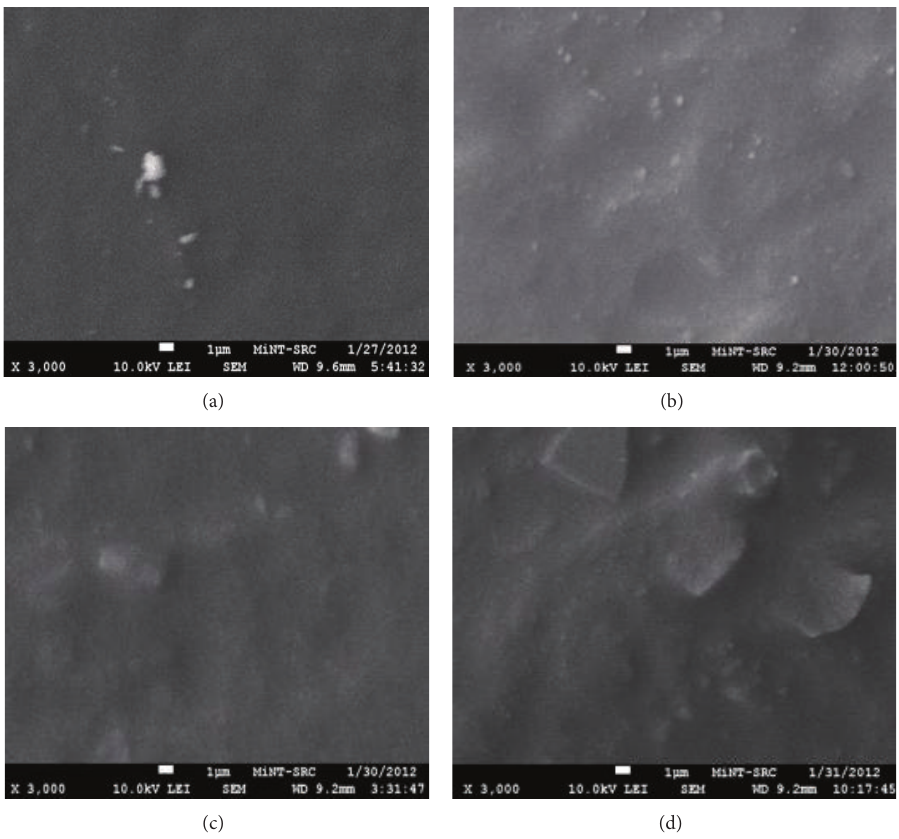
Figure 3: FESEM images of the samples. (a) Sample A1, (b) sample A3, (c) sample A5, and (d) sample